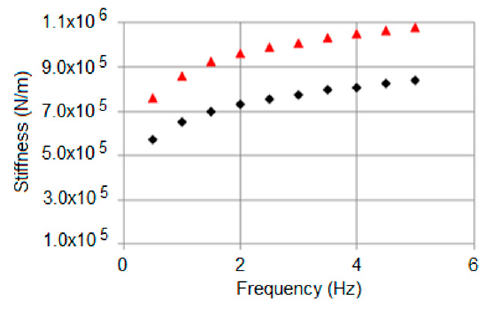
Machines 2019 , 7 , x FOR PEER REVIEW